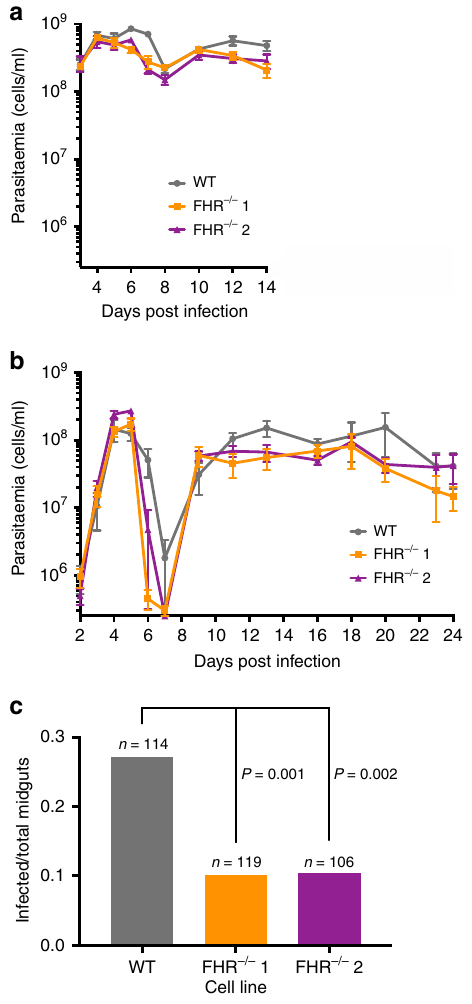
Fig. 6 The transmission of T. brucei FHR − / − cell lines to tsetse fl ies from mice was signi fi cantly reduced compared with FHR + / + . a , b Mean mouse blood parasitaemia of parental FHR + / + and two independent FHR − / − clones, with error bars representing the SEM. a Five immunosuppressed BALB/c mice were infected with each cell line and monitored from days 3 – 14 post infection. b Five immunocompetent BALB/c mice were infected with each cell line and monitored from days 2 – 24 post infection. c Tsetse fl ies were fed on infected mice and transmission of the infection was evaluated by the dissection of >100 midguts per cell line on days 6 – 16 post infection. The total number is derived from seven replicates per cell line. The number of infected midguts over the total dissected midguts is plotted, whereby 31/114 were infected for FHR + / + , 12/119 for FHR − / − clone 1, and 11/106 for FHR − / − clone 2. The observed difference between the FHR + / + and each of the FHR − / − clones was signi fi cant ( P < 0.002 for each cell line by χ 2 -test). Source data are provided as a Source Data fi